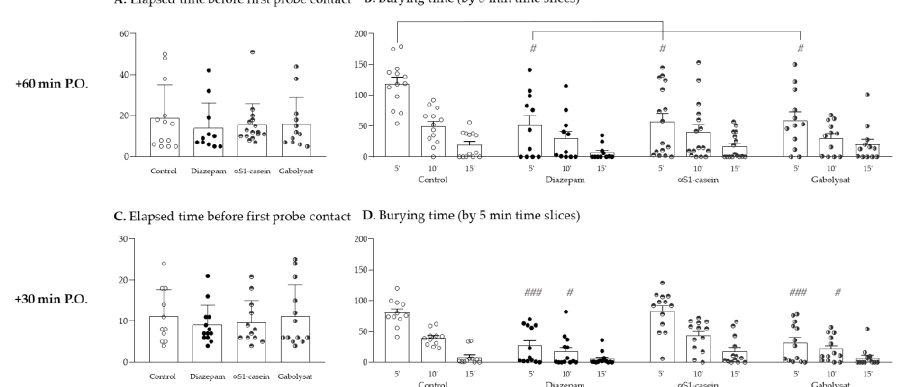
Figure 2. Conditioned behavioral test performed 60 min ( A , B ) and 30 min ( C , D ) after oral gav- age. Figure 1 displays the latency for first contact to probe, as a control measurement of motiva- tion/locomotor activity for all animals’ groups. Figure 1 display probe-burying behavior during the test (by 5 min time slices), reflective of anxiety levels. A total of 102 rats were used. Groups sizes were 13, 11, 16 and 12 for control, diazepam, α S1–casein hydrolysate and Gabolysat ® , respectively, when the test was performed 60 min after gavage ( A , B ); corresponding 13, 11, 13 and 13 when test was performed 30 min after gavage ( C , D ) (ANOVA with repeated measurement, post-hoc test: # p < 0.05 and ### p < 0.001 compared to respective control